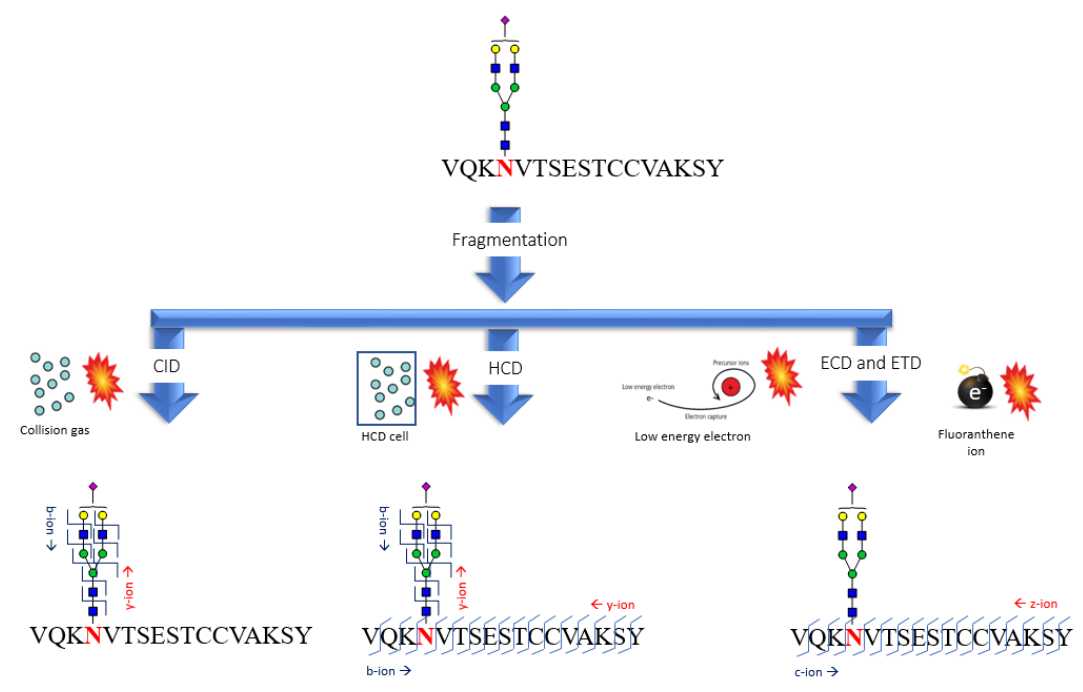
Figure 4. Mechanism of collision induced dissociation (CID), high-energy collision dissociation (HCD), electron-capture dissociation (ECD), and electron transfer dissociation (ETD) fragmentation. The glycopeptide shown in Figure 3A is used as example.